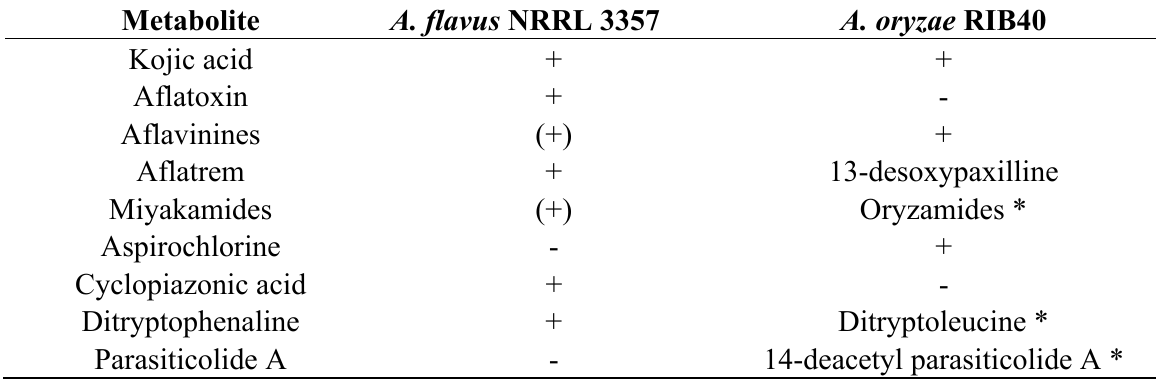
Table 1. LC-MS de-replication of some of the important secondary metabolite pathways from the two full genome sequenced siblings, A. flavus (NRRL 3357) and A. oryzae (RIB40). Based on 7 day fermentation on solid WATM agar in the dark. (+) indicates the presence of these types of compounds in A. flavus based on UV spectroscopic analysis. * New compounds reported here for the first